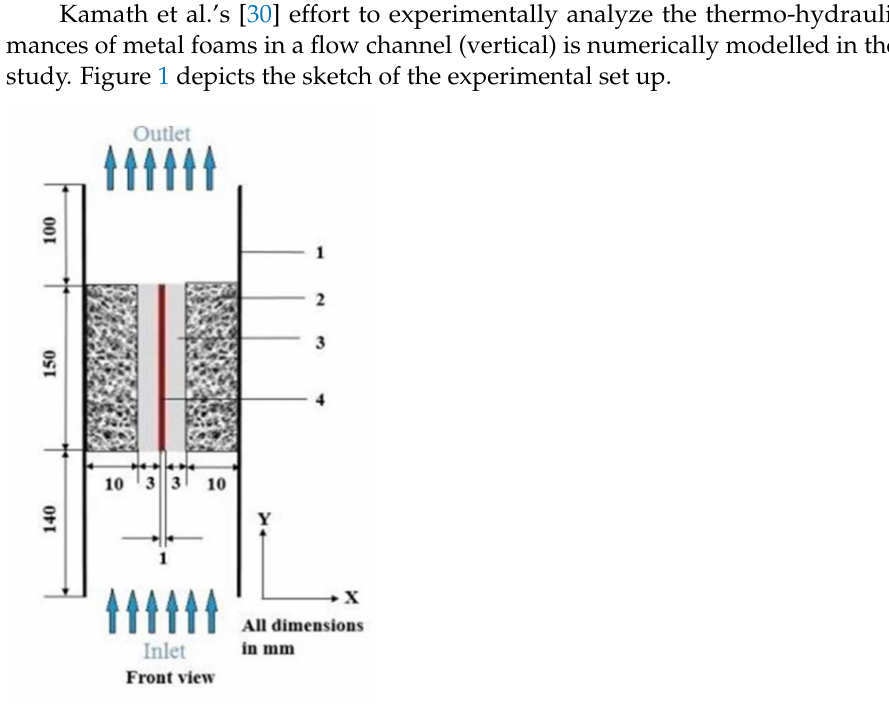
Figure 1. Sketch depicting the front view of the experimental set up used in [9] which has a depth of 250 mm. It is mainly constituted by the following: (1) vertical channel, (2) metal foam, (3) aluminum plate and (4)